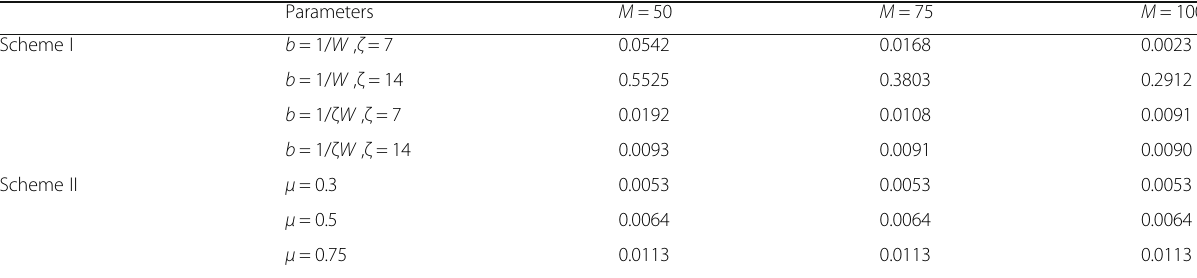
Table 1 Reconstruction errors of sampling scheme proposed in this paper and that in [15]